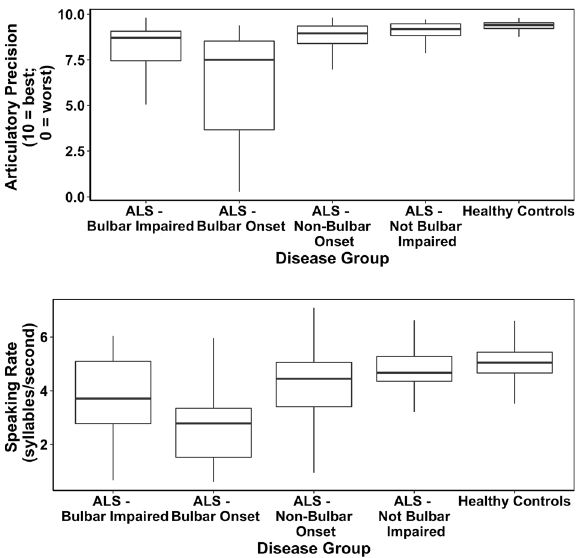
Fig. 1 Boxplots for healthy controls, ALS participants with no bulbar impairment (normal ALSFRS-R scores for speech, swallow- ing, and salivation), ALS participants with bulbar impairment (at least one score below 4 in the ALSFRS-R scores for speech, swallowing, and salivation), and ALS participants with bulbar- onset (type of ALS onset). All data points are used. Note: the mixed- effects models indicated that the healthy controls signi fi cantly differed from all ALS participants ( p -value = 0.005 and p -value < 0.001 for AP and SR, respectively) and from ALS participants with no bulbar impairment ( p -value = 0.024 and 0.009 for AP and SR, respectively). Center line = median; box limits = upper and lower quartiles; whiskers = 1.5× interquartile